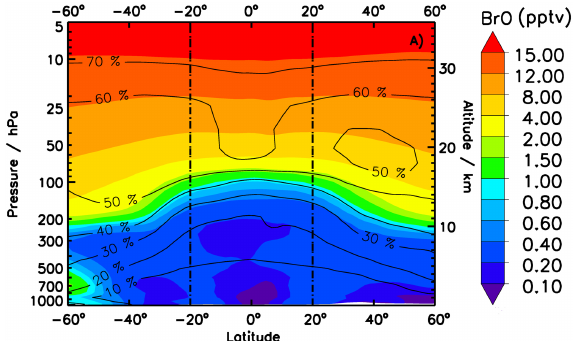
Figure 6. Annual zonal average BrO distributions between 60 ◦ N and 60 ◦ S. The color scale represents absolute values (pptv), while black contour lines show the percentage contribution of BrO to Br y